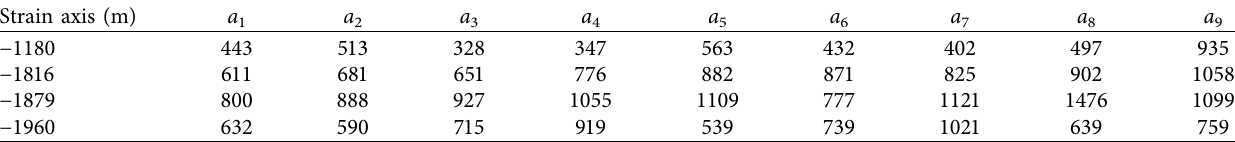
Table 2: Strain recovery of different strain axes in deep core.